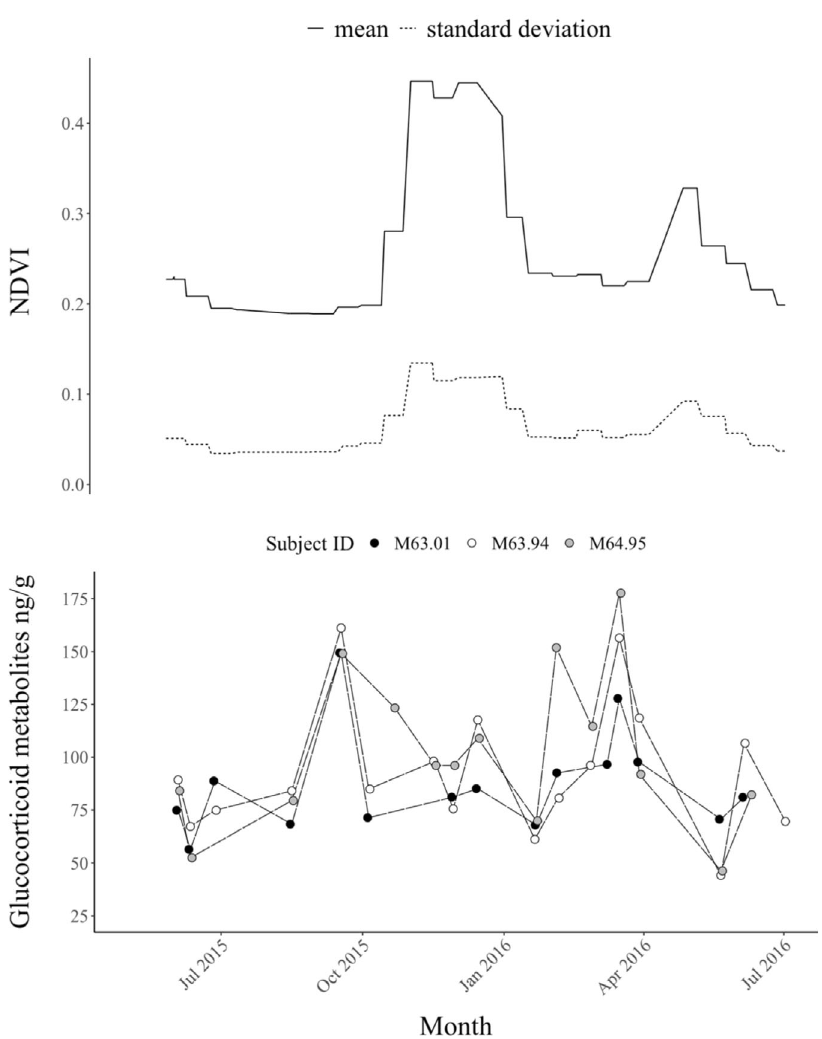
Fig. 3 Depiction of the strong correlation between fecal glucocorticoid metabolite concentrations and seasonality. NDVI (normalized difference vegetation index — a measure of primary productivity) mean (solid line) and standard deviation (dotted line) over the course of the study above the glucocorticoid metabolite concentrations in ng/g (nanograms of metabolites per gram of fecal matter) of three study elephants from the same family. Circles depict sample fecal glucocorticoid metabolite concentrations, with samples from each elephant distinguished according to fi ll color (white, black, or gray). Long-dashed lines emphasize oscillations in a single elephant ’ s concentrations over time. Glucocorticoids fl uctuated most in relation to changes in primary